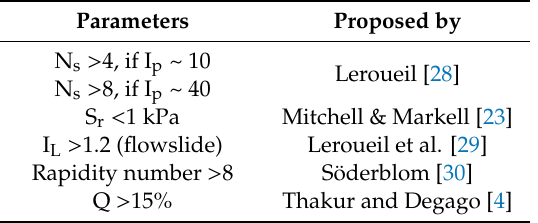
Table 2. Parameters that render a slope susceptible to large